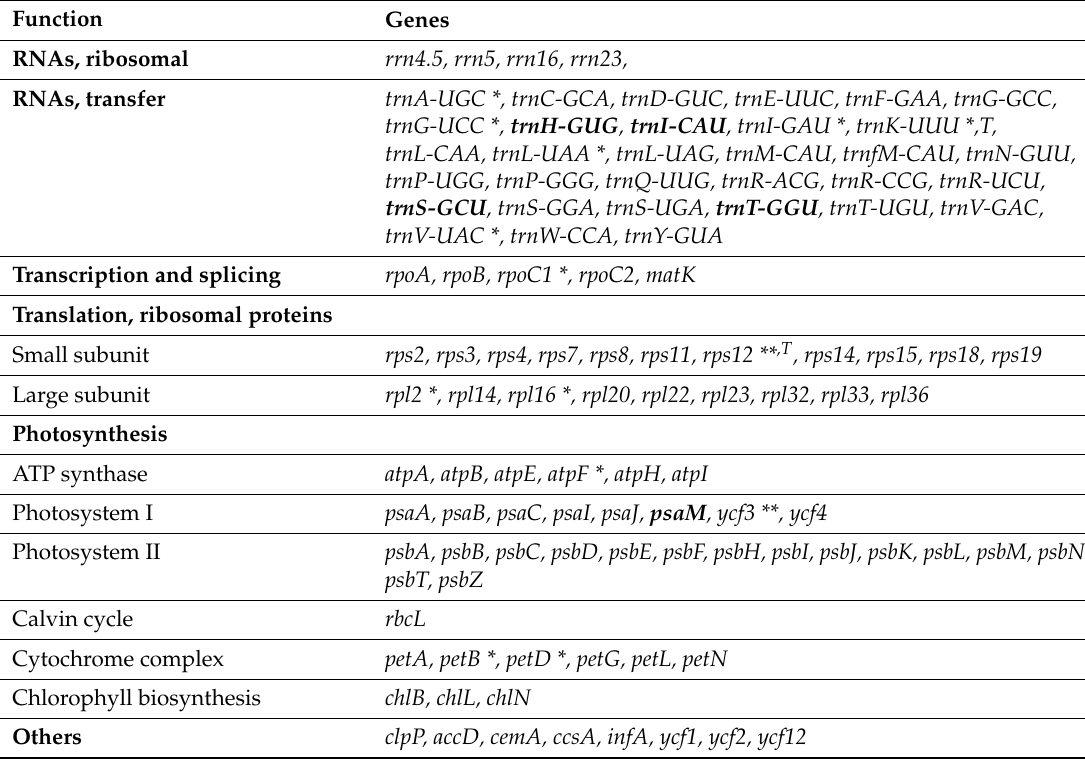
Table 3. List of genes annotated in the chloroplast genome of Pinus densiflora sequenced in this study.